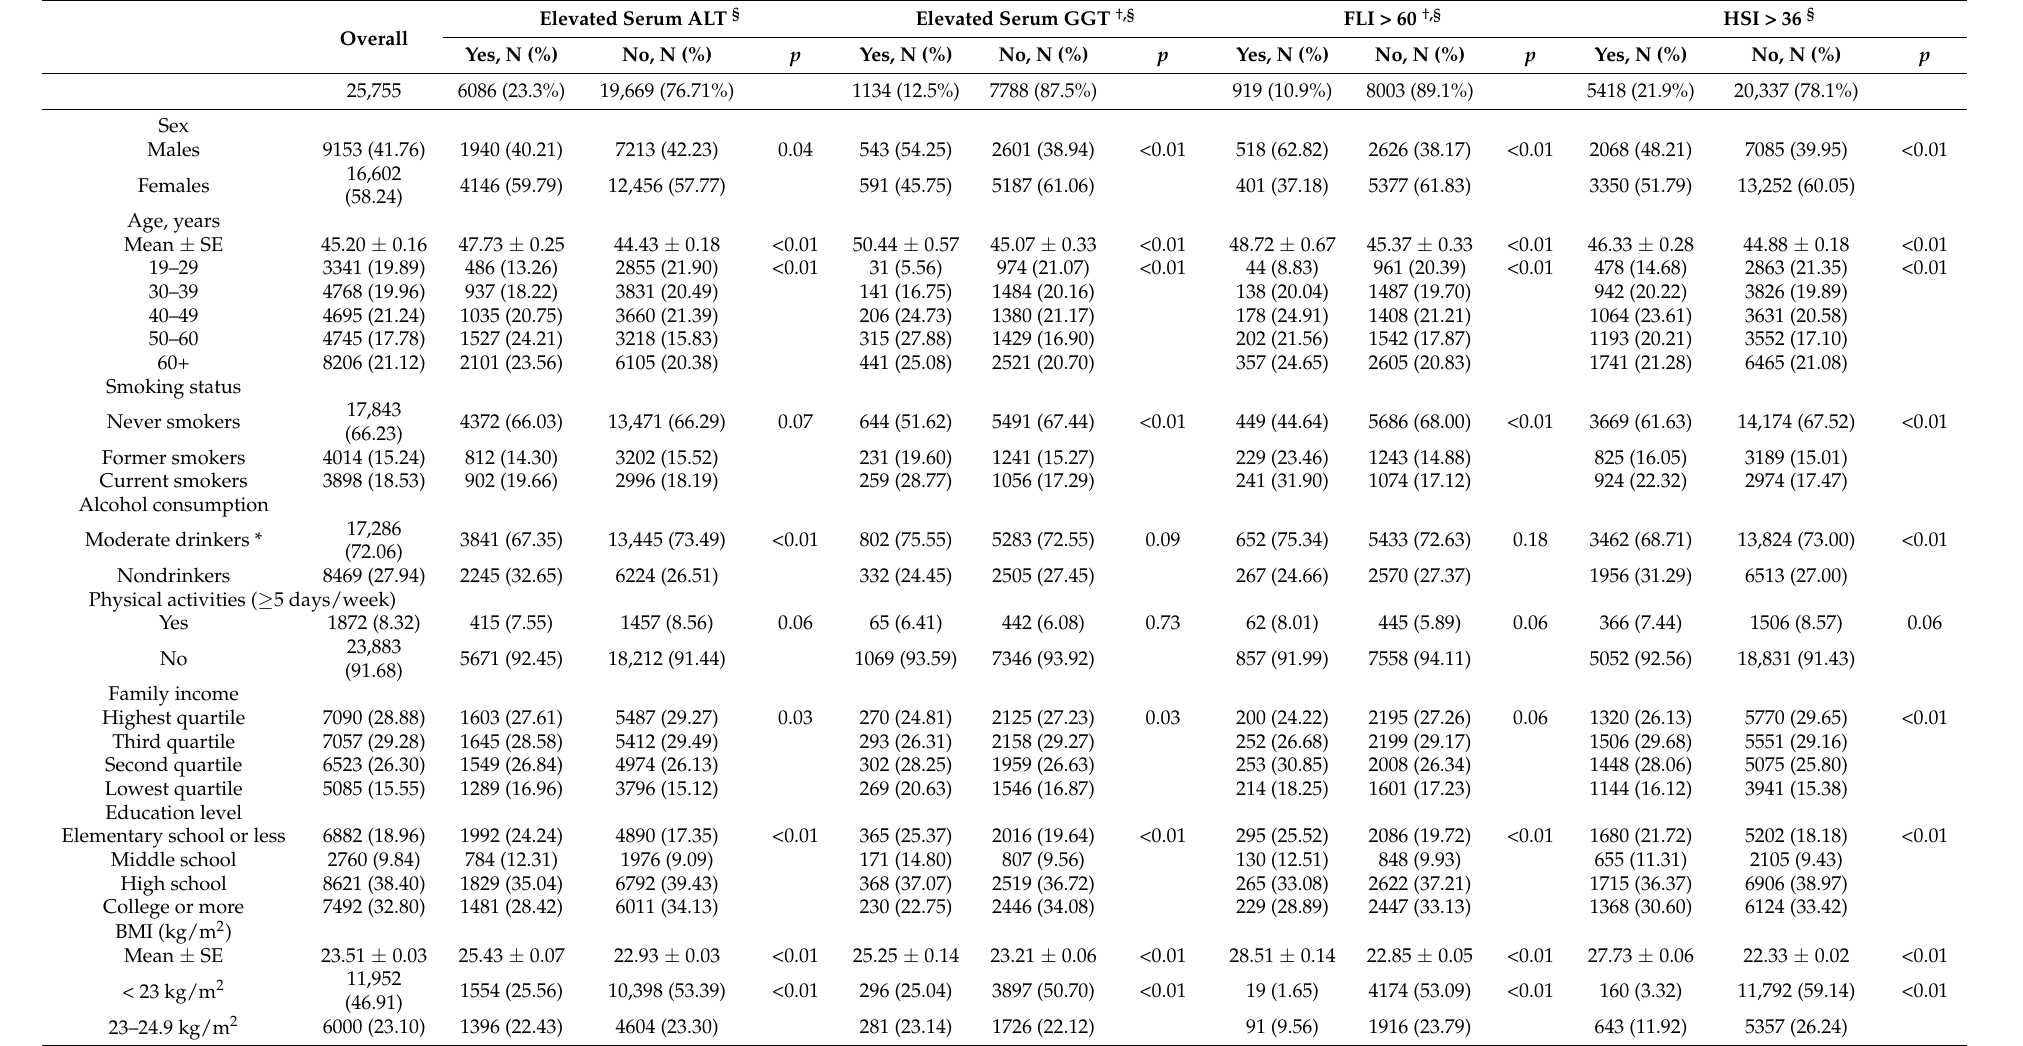
Table 1. Demographic characteristics of subjects eligible for the study, KNHANES